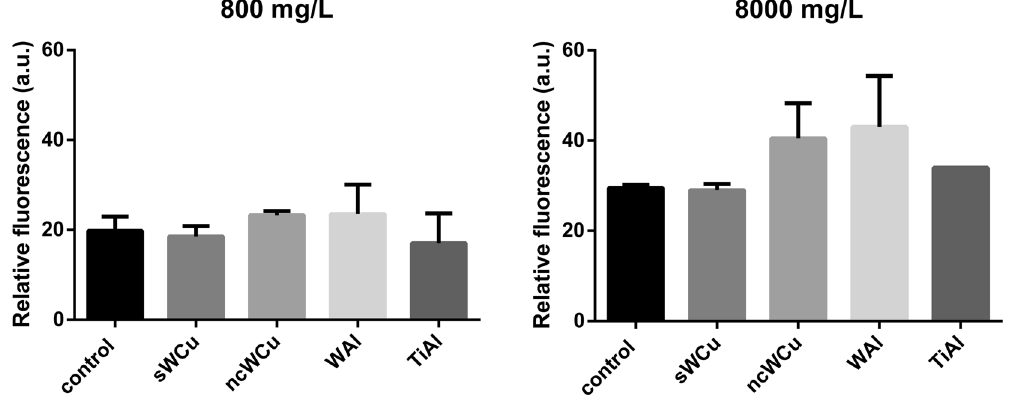
Figure 5. ROS induction analysis of S. cerevisiae cells exposed to different metal powders during 2 h at two different concentrations (800 and 8000 mg/L). Results are expressed as arbitrary fluorescence values. Data represent the mean ± standard deviation, SD. Differences were established using a One-way ANOVA followed by Dunnett post hoc test to compare every mean with the control, and considered significant at P ≤